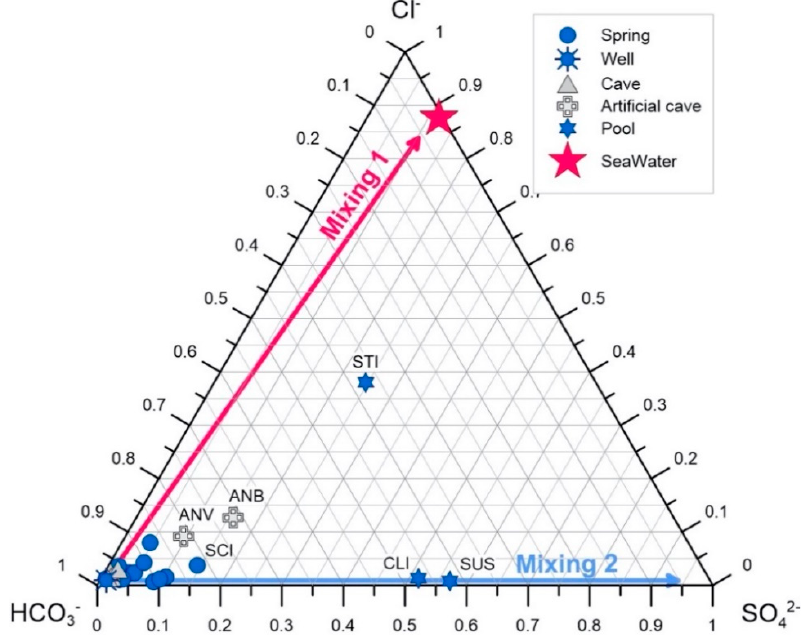
Figure 3. Ternary diagram showing the relative abundances of the three main anions (HCO 3 , Cl and SO 4 ) determined in the sampled waters.